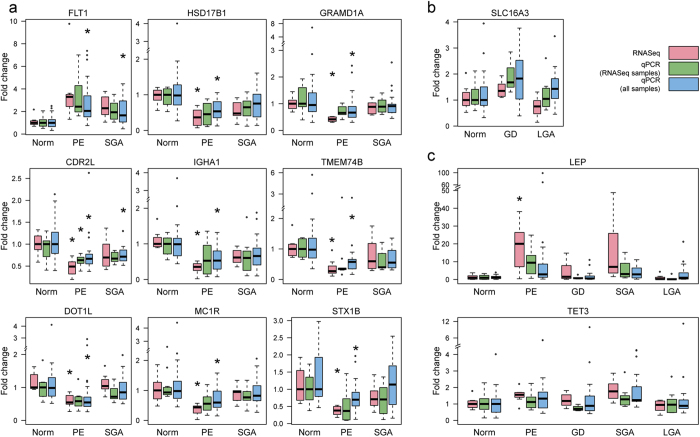
Examples of technical replicates from the experimental validation of differentially expressed placental genes in pregnancy complications.Plots represent gene expression fold changes relative to the median value of the normal pregnancy samples (treated as the reference level = 1) in the discovery RNA-Seq dataset (pink; n = 8 samples/group), in the validation by Taqman RT-qPCR (green; n = 8 samples/group) and in the complete Taqman RT-qPCR dataset (blue; n = 24 samples/group). (a) Genes with the highest statistical significance in gene expression shift in pre-eclamptic (PE) placentas (RT-qPCR: FDR <0.05; Supplementary Table S3) show concordant effect directions in the PE and small-for-gestational-age (SGA) groups. (b) Placental expression of SLC16A3 in gestational diabetes (GD) and large for gestational age (LGA) groups. (c) LEP and TET3 show elevated transcript level in PE and SGA placentas compared to other pregnancy outcomes. Asterisks (*) indicate differential expression meeting the statistical significance criteria either for the RNA-Seq (DESeq: FDR < 0.1, DESeq2: FDR < 0.05) or RT-qPCR (FDR < 0.05) datasets. CDR2L, cerebellar degeneration-related protein 2-like; DOT1L, DOT1-like histone H3K79 methyltransferase; FLT1, fms-related tyrosine kinase 1; GRAMD1A, GRAM domain containing 1A; HSD17B1, hydroxysteroid (17-beta) dehydrogenase 1; IGHA1, immunoglobulin heavy constant alpha 1; LEP, leptin; MC1R, melanocortin 1 receptor (alpha melanocyte stimulating hormone receptor); TET3, tet methylcytosine dioxygenase 3; TMEM74B, transmembrane protein 74B; SLC16A3, solute carrier family 16 (monocarboxylate transporter); STX1B, syntaxin 1B.